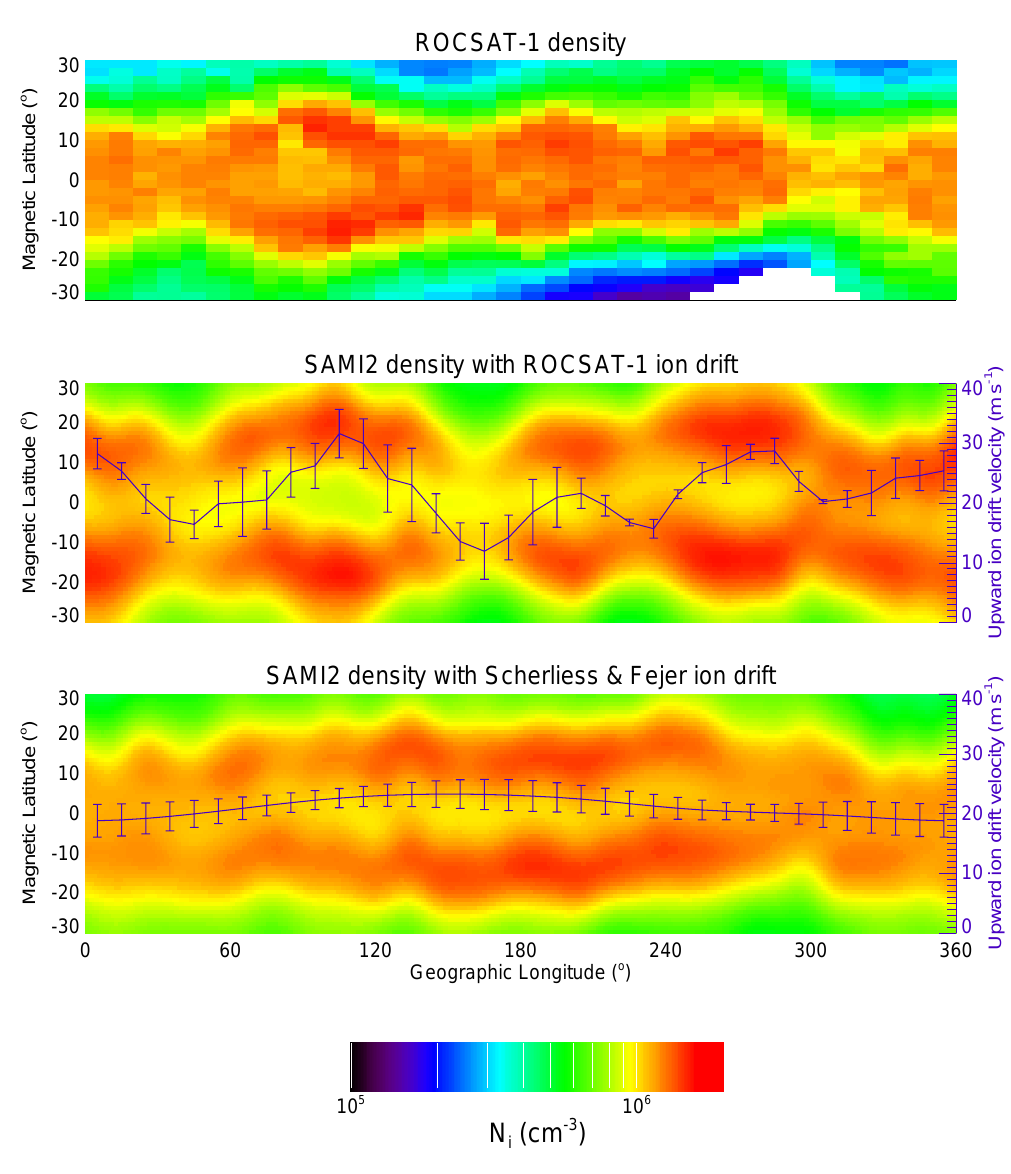
Fig. 6. Comparison of the longitudinal density structures at 12:00–14:00LT during equinox obtained from ROCSAT-1 (top) with SAMI2 model ionosphere (middle and bottom). The top panel is the same as Fig. 1. The middle panel shows the SAMI2 model density map obtained using the ROCSAT-1 drift data. The blue curve shows the mean vertical ion velocity at 12:00–14:00LT observed from ROCSAT-1. The vertical bars show the standard deviations. The bottom panel shows the SAMI2 model density map obtained using the SF E × B drift model. The blue curve shows the mean vertical ion velocity at 12:00–14:00LT obtained from the SF E × B drift model. The SAMI2 model simulations were conducted on 26 March